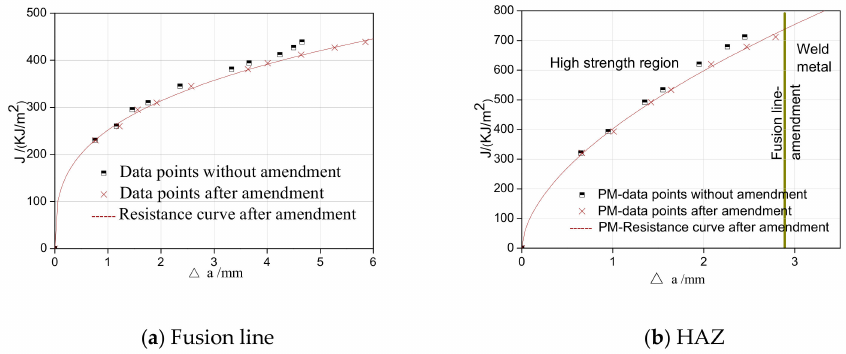
Figure 20. Resistance curves after the crack length amendment of the homogeneous material. ( a ) Parent material; ( b ) Weld metal.